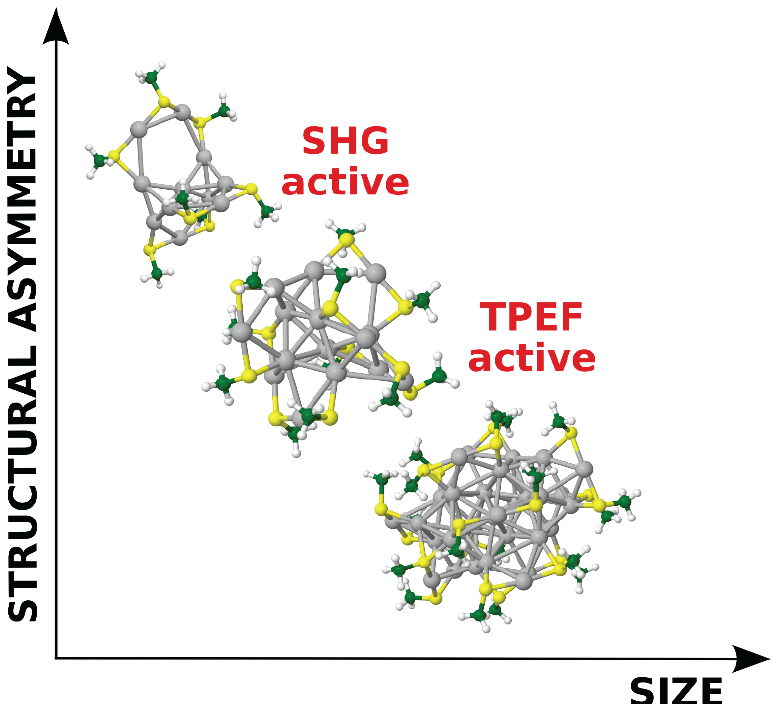
Figure 4. NLO properties of liganded metal nanoclusters as a function of size and asymmetry (Ag 11 , Ag 15 , and Ag 32 are shown as examples).